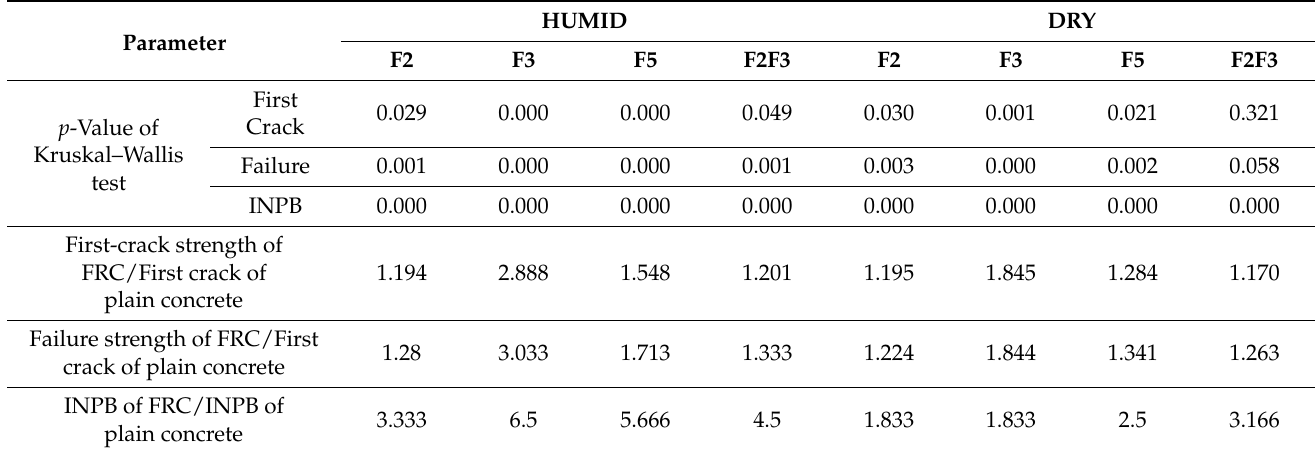
Table 9. Comparison of the impact strength of FRC versus plain